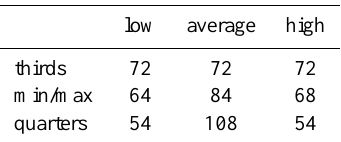
Table 1. Numbers of months classified with low, moderate, and high solar activity in individual stratifications (“thirds”, “min/max”,